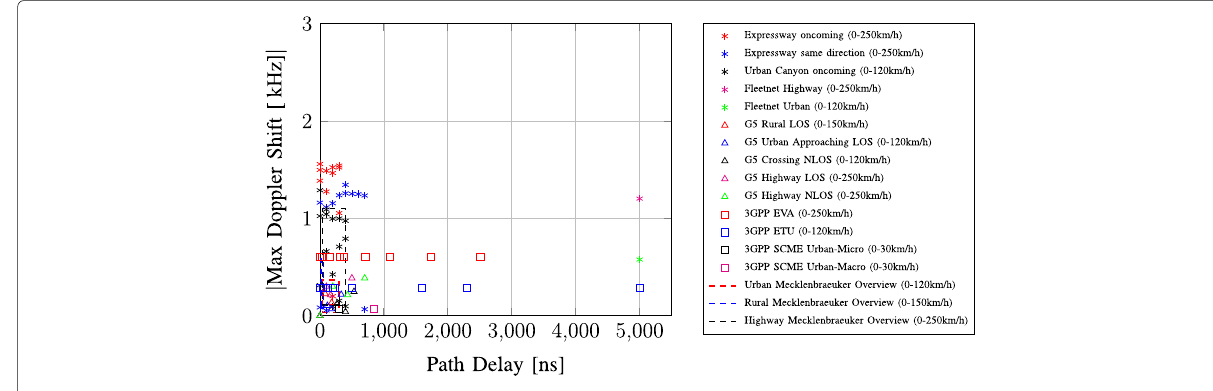
Fig. 21 Doppler vs. delay relationship of cellular and V2V